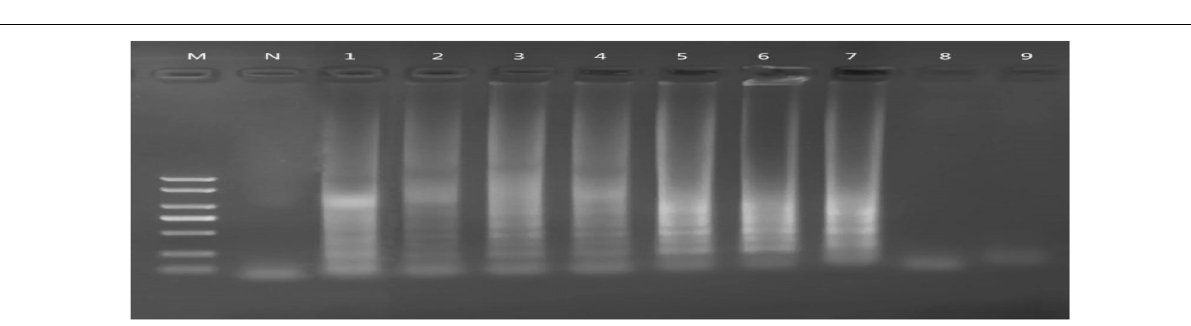
FIGURE 3 | Sensitivity of peg-344 LAMP. M: DL2000 DNA Marker; N: Negative control; 1 ∼ 9 DNA concentrations: 475, 47.5, 4.75, 4.75 × 10 - 1 , 4.75 × 10 - 2 , 4.75 × 10 - 3 , 4.75 × 10 - 4 , 4.75 × 10 - 5 , and 4.75 × 10 - 6 ng/ µ L, respectively.